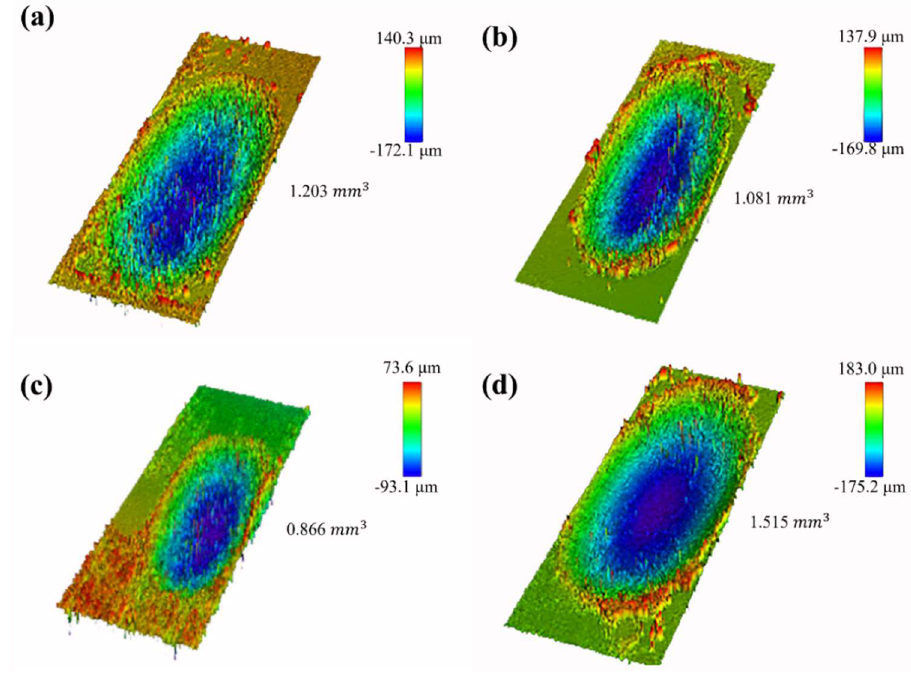
Figure 9. 3D profiles of wear tracks of the Al x Ti 1− x coatings: ( a ) Al 1 Ti 0 , ( b )Al 0.5 Ti 0.5 , ( c ) Al 0 Ti 1 , ( d ) Substrate.